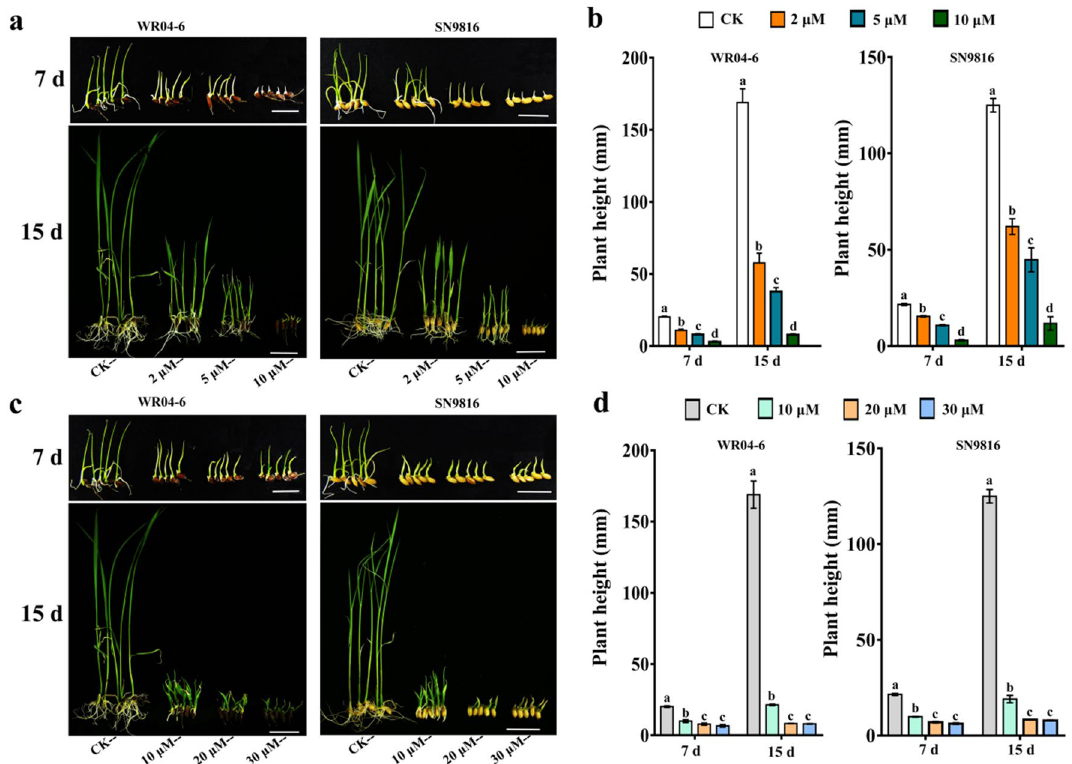
Figure 2. The growth and development of WR04-6 and SN9816 seedlings were retarded when they were continuously treated with ABA or diniconazole. ( a ) Growth of WR04-6 and SN9816 seedlings after 7 d and 15 d of continuous treatment with ABA. Bar = 2 cm. ( b ) Comparison of plant height (mm) of WR04-6 and SN9816 seedlings after treatment with different concentrations of ABA for 7 days and 15 days. ( c ) Growth of WR04-6 and SN9816 seedlings with continuous diniconazole treatment for 7 d and 15 d. Bar = 2 cm. ( d ) Comparison of plant height (mm) of WR04-6 and SN9816 seedlings after treatment with different concentrations of diniconazole for 7 and 15 days. Error bars represent SEs (n = 3). Different letters over the bars indicate treatments that are significantly different ( p <